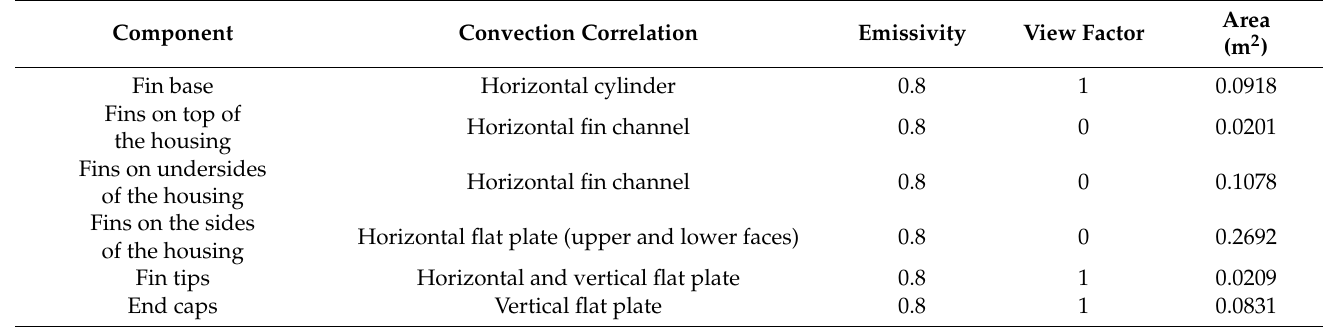
Table 2. Segregation of the compound structure of TEFC